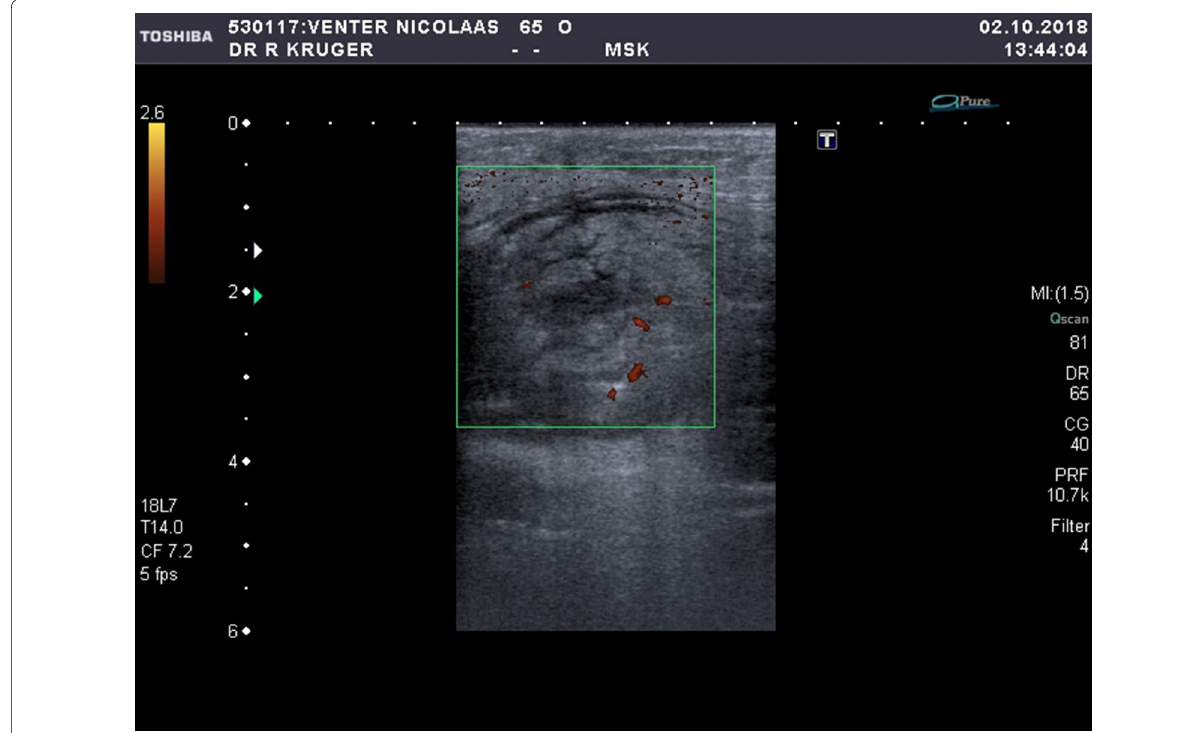
Fig. 6 Increased vascularity noted with Power Doppler imaging